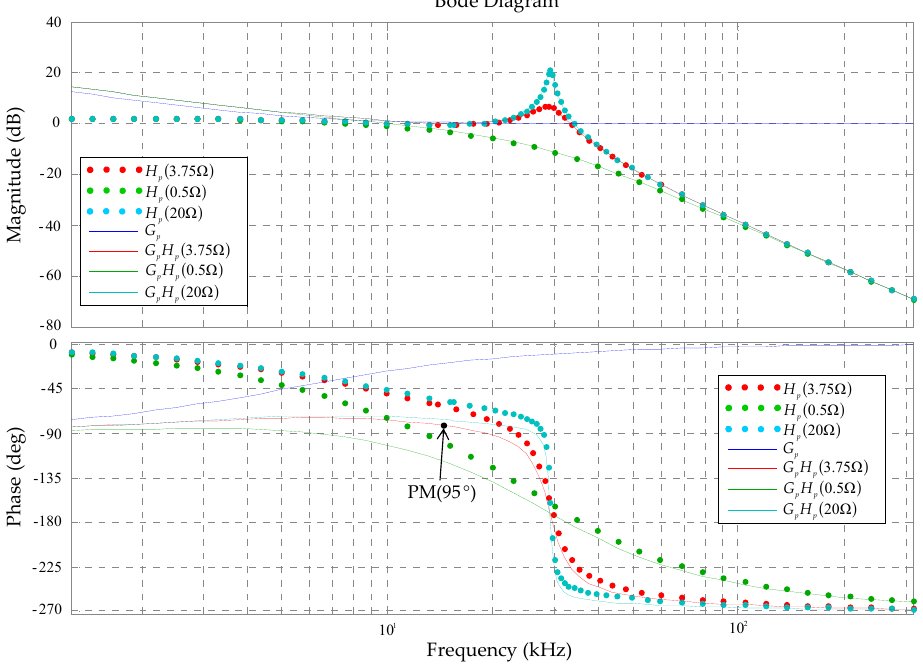
Figure 7. Bode plots for PV voltage loop control design.